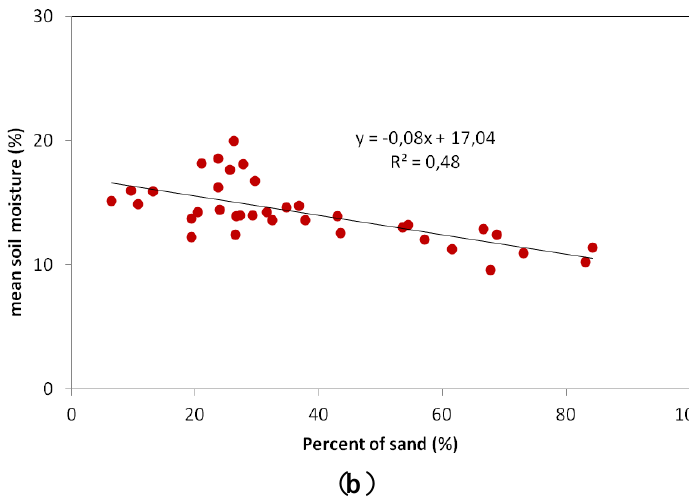
Figure 8. Relationship between mean soil moisture, estimated from 7 radar moisture maps, and soil texture characteristics, for 34 test fields: ( a ) clay content (%); ( b ) sand content (%).